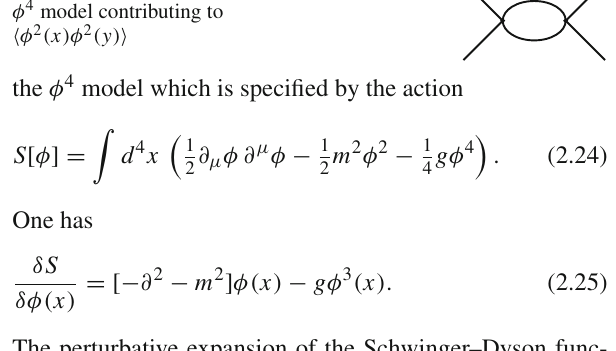
Fig. 1 One loop diagram of the φ 4 model contributing